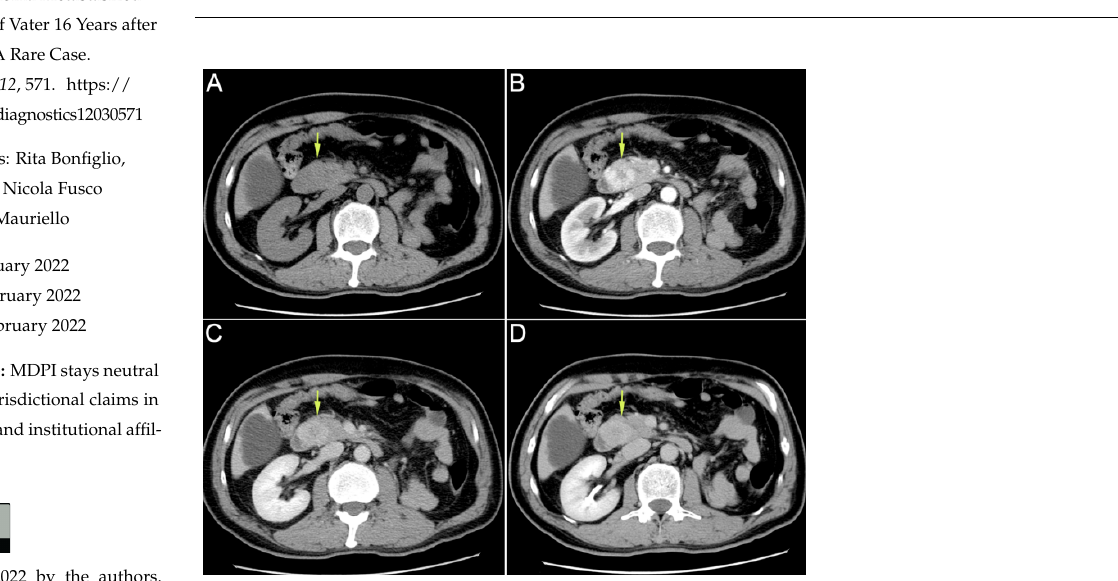
Figure 1. Enhanced upper abdominal computed tomography (CT) performed in the local hospital indicated ampullary mass. ( A ): plain scan phase; ( B ): arterial phase; ( C ): venous phase; ( D ): delayed phase. A 59-year-old male patient was hospitalized for “recurrent hematochezia for 8 days”. En- hanced upper abdominal computed tomography (CT), performed in the local hospital, indicated ampullary mass. On CT, the tumor showed uneven enhancement in the arterial phase, but the enhancement significantly weakened in the venous phase and delayed phase. Therefore, this